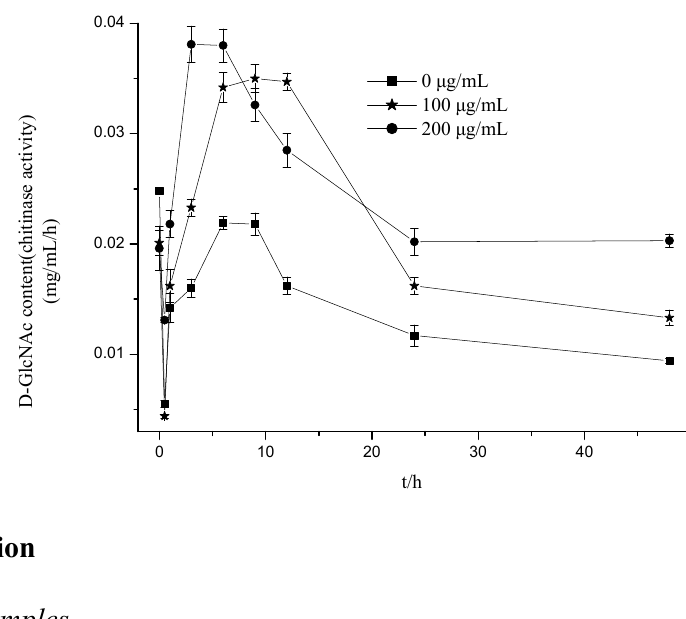
Figure 4. Effect of citral on the chitinase activity of M. grisea